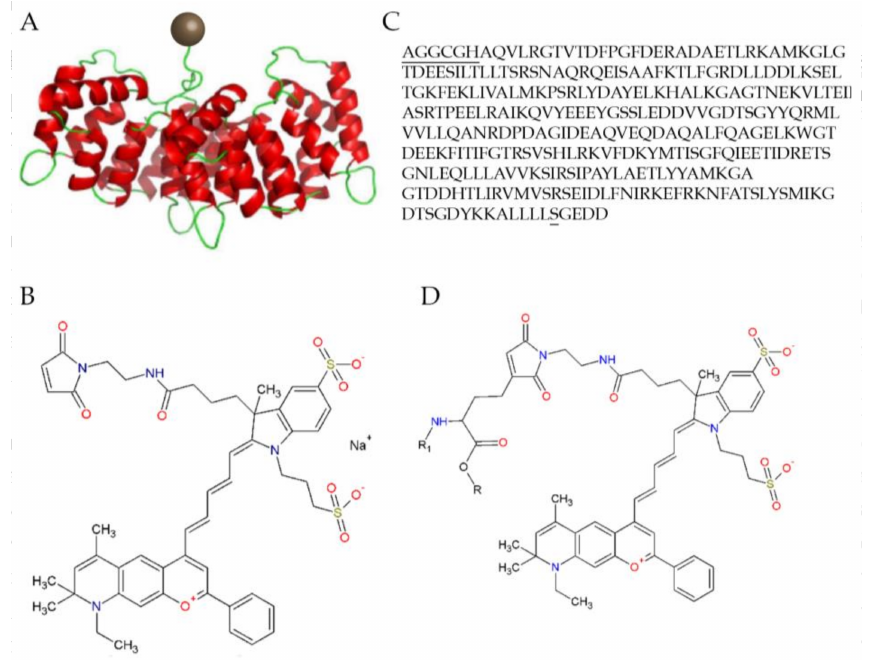
Figure 3. The structure of the Dy-776-mal labelled annexin V128 molecule: ( A ) Diagrammatic representation with the Dy-776-mal label represented with a brown sphere and the annexin molecule in red and green; ( B ) The molecular structure; ( C ) The optimized amino acid sequence of Anx V128, with the additional amino acids at the N-terminus containing the cysteine and mutated serine; and ( D ) The molecular structure of the fluorescent conjugation of ANX776